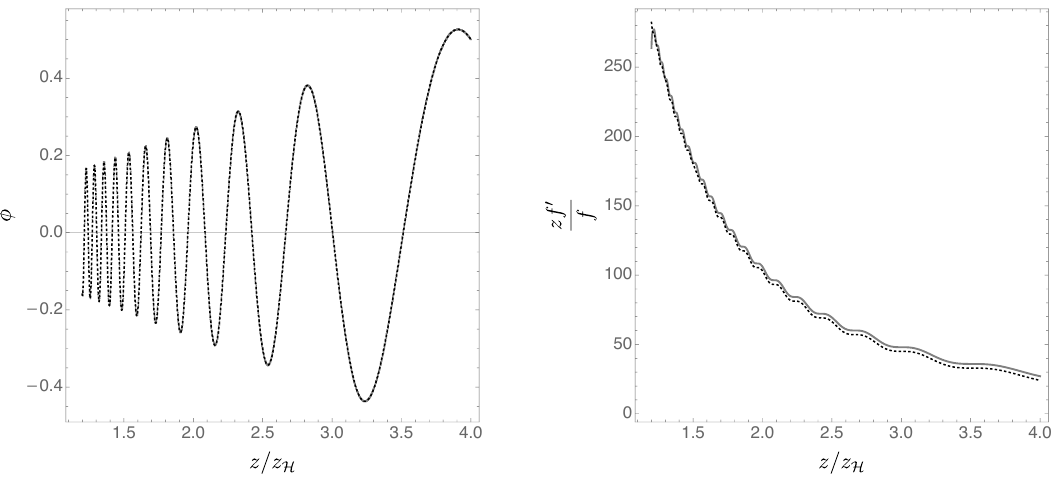
Figure 4: Josephson oscillations in the scalar field φ and corresponding imprint in the metric derivative z f (cid:48) / f . The solid gray line is numerical data and the black dotted curves are fits to the expressions (21) and (22). These are at T / T with m 2 = − 2 and q =